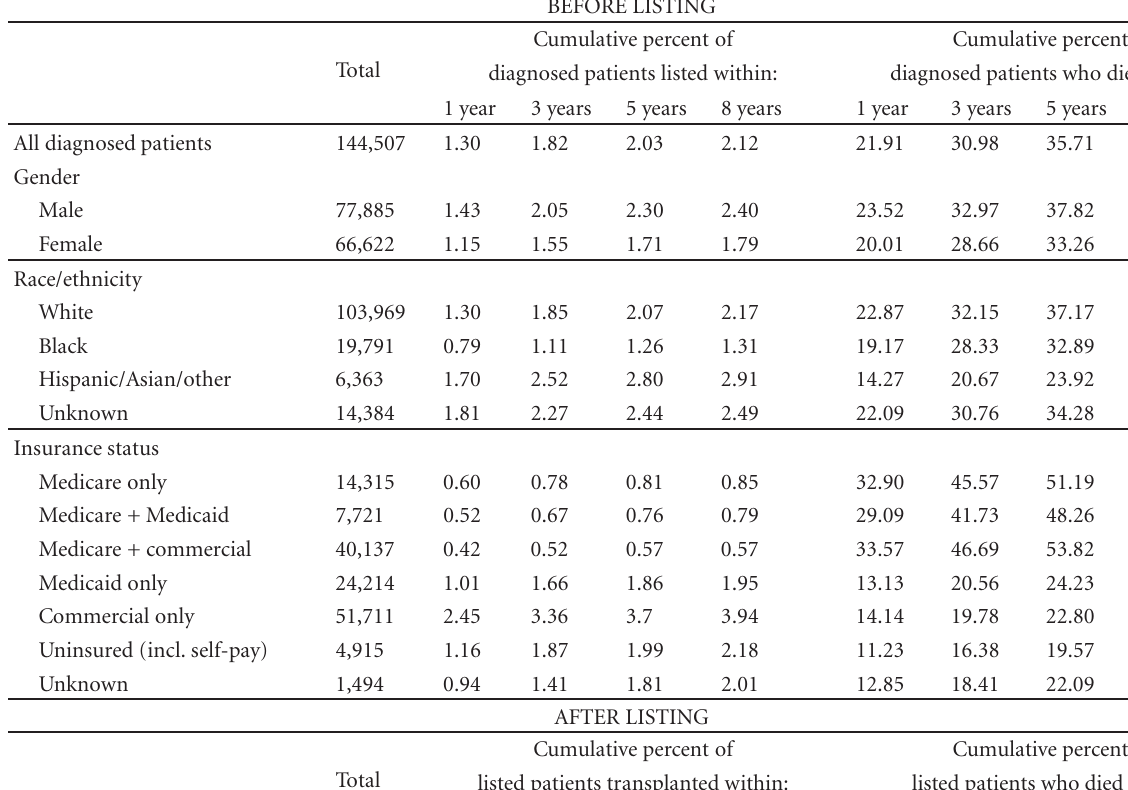
Table 2: Unadjusted time to listing and time to transplantation, controlling for competing risk of death. BEFORE LISTING Cumulative percent of Cumulative percent